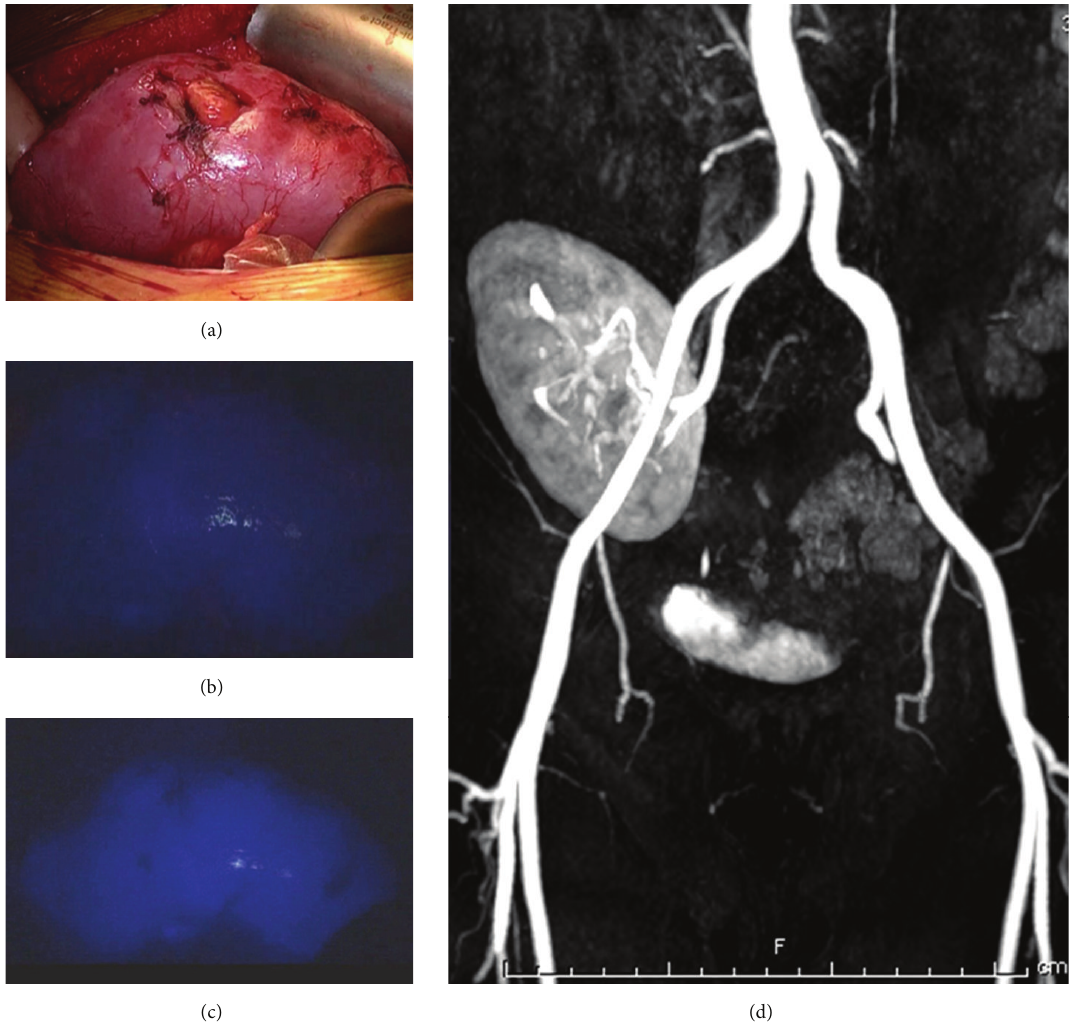
Figure 2: Intraoperative aspect of the transplanted kidney (a) and visualization of the parenchyma at the time of indocyanine green injection (b) and after the revascularization with real-time fluorescence imaging (c). Follow-up control with magnetic resonance angiography